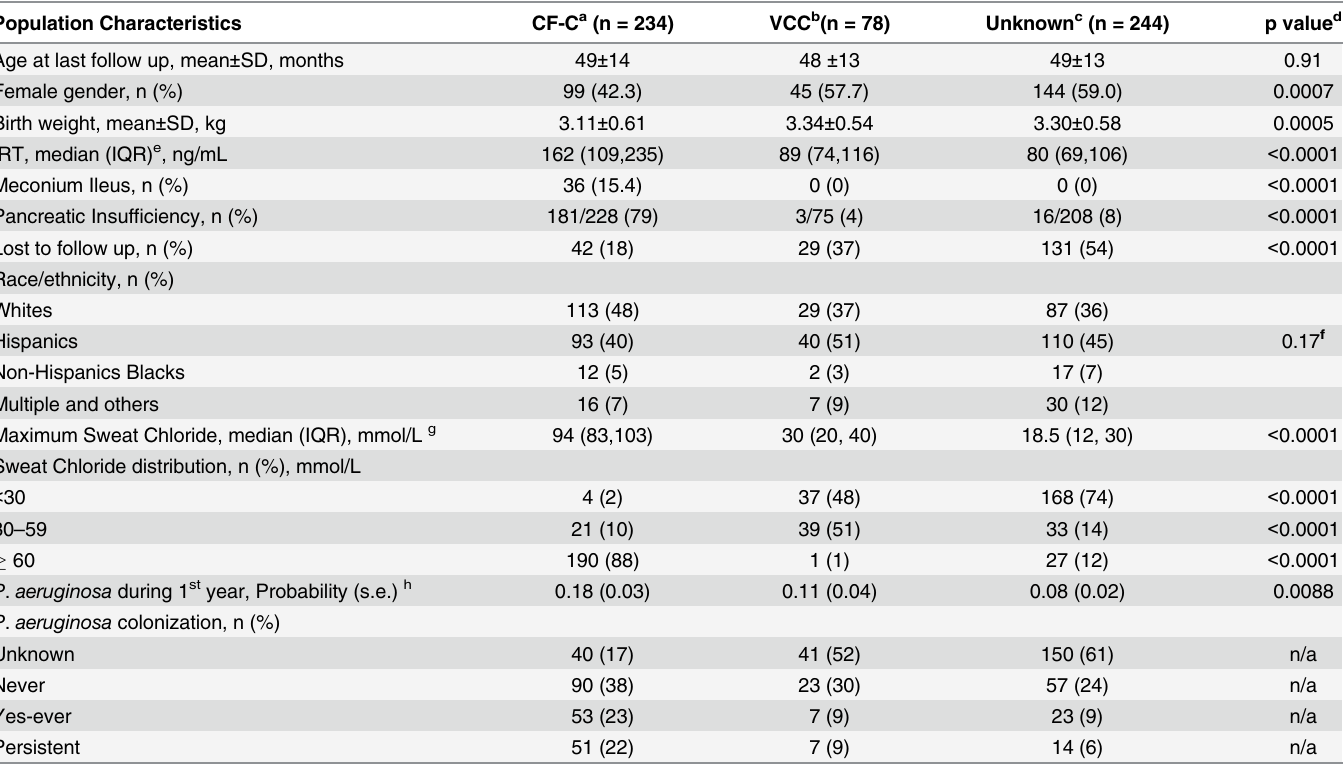
Table 1. Description of the Study Population and phenotype